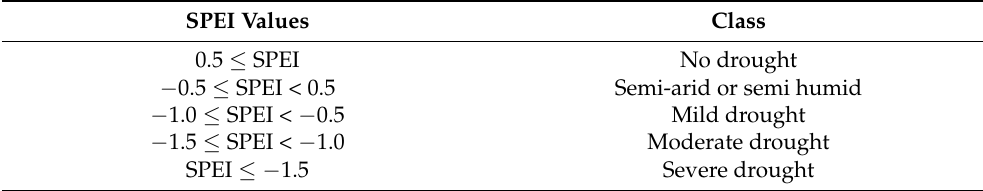
Table 1. Drought classification criteria based on